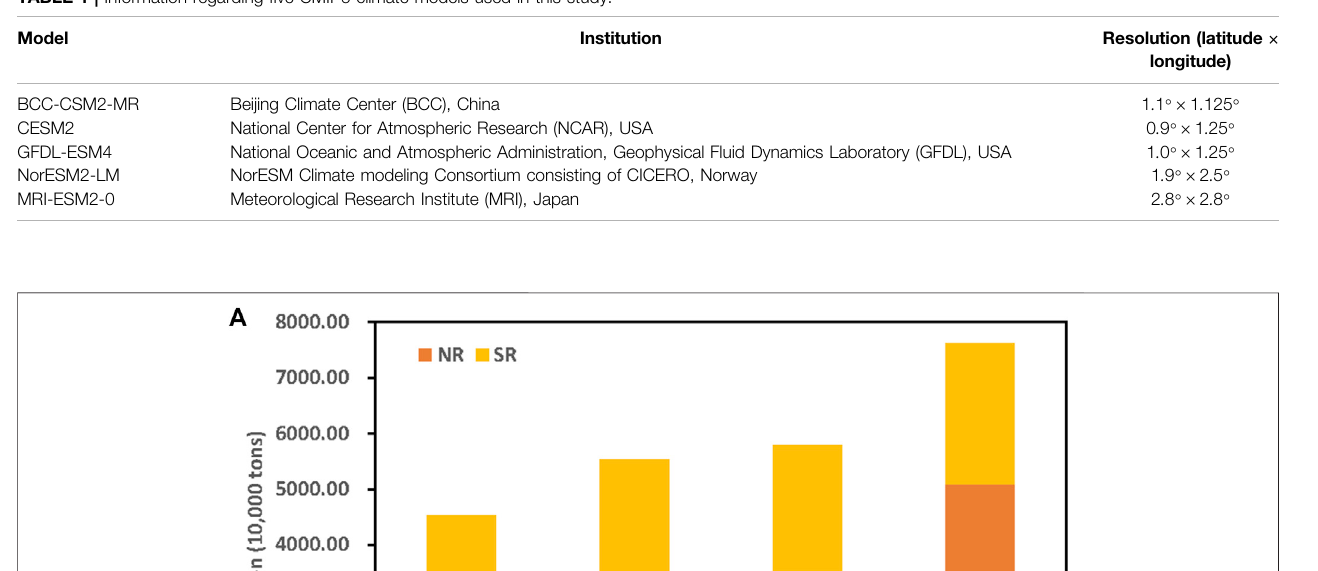
TABLE 1 | Information regarding fi ve CMIP6 climate models used in this study.